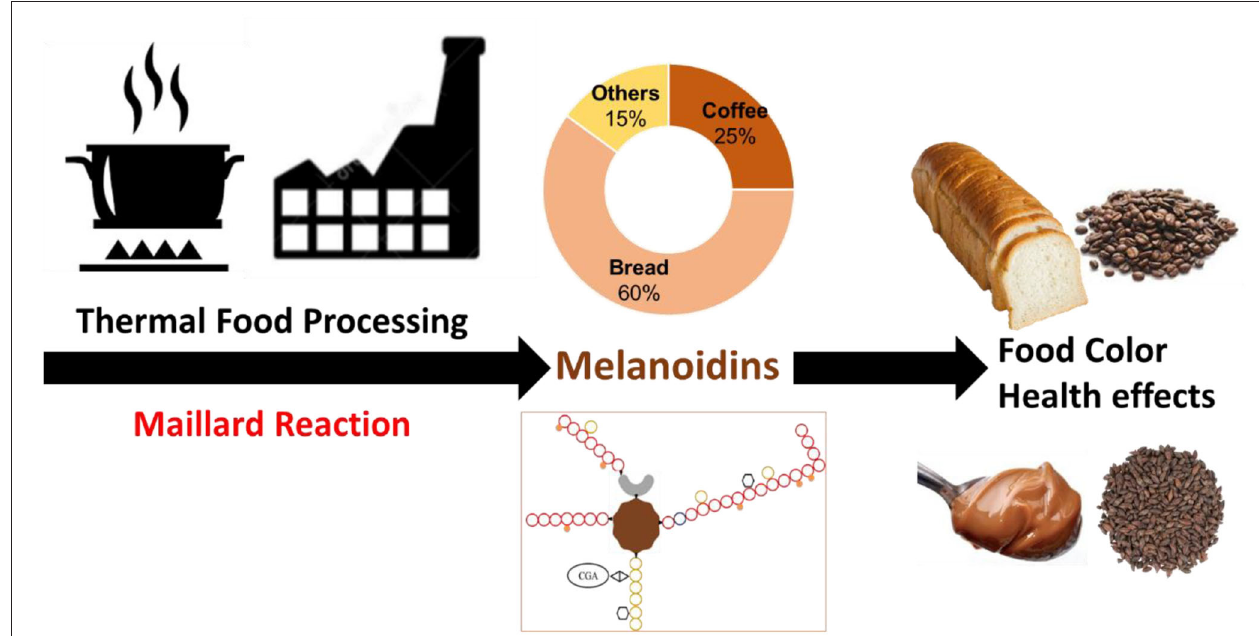
FIGURE 1 | Nature, main dietary sources and relative contribution to melanoidin consumption, and functions of dietary